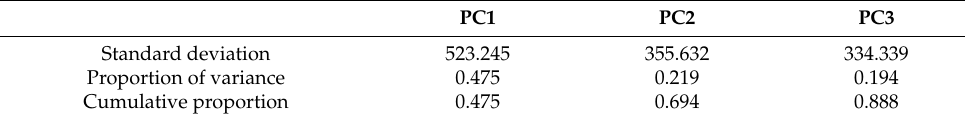
Table 2. Proportions of variance explained by the first three PCA